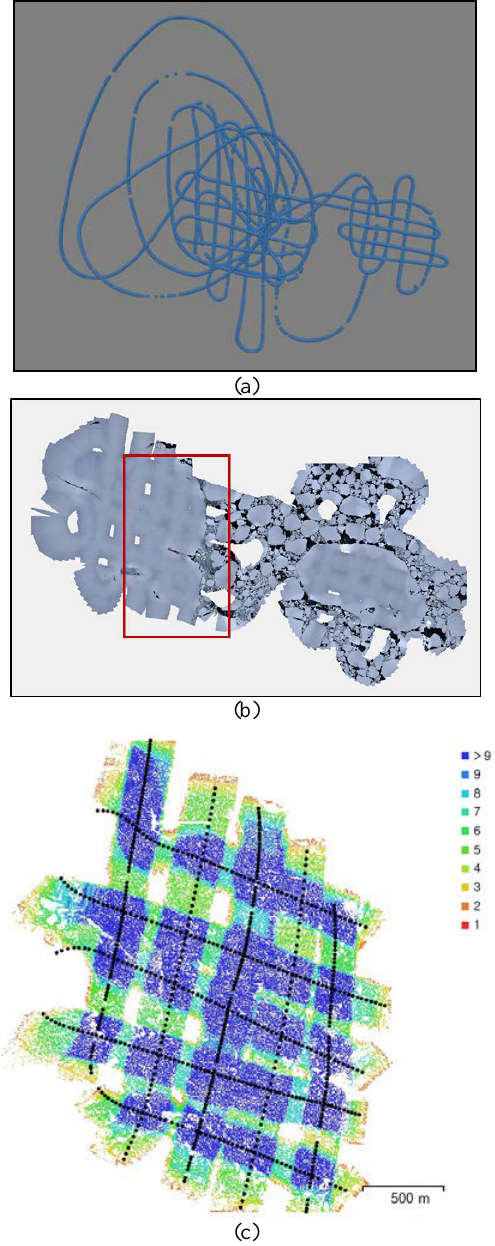
Figure 3. Helicopter-borne image acquisition results: (a) positions of image acquisition, (b) preliminarily mosaicked image using whole acquired images with a target area (red box) and (c) number of overlap images of the selected images for further sea ice drift compensation analysis.